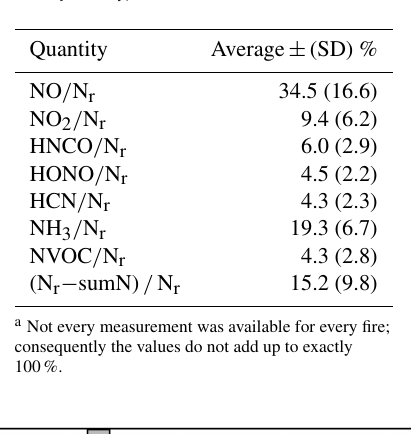
Table 3. Summary of X i / N r measurements for all stack burns a .